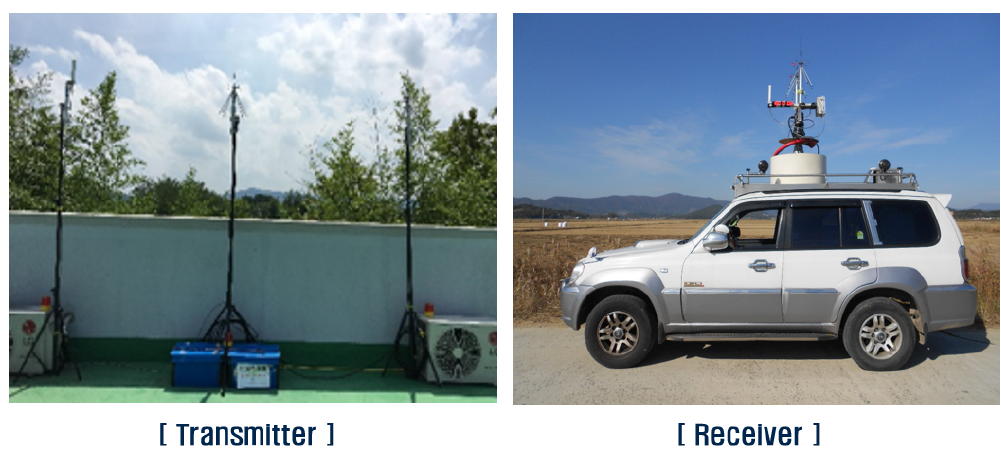
Figure 6. Block diagram of the measurement system.